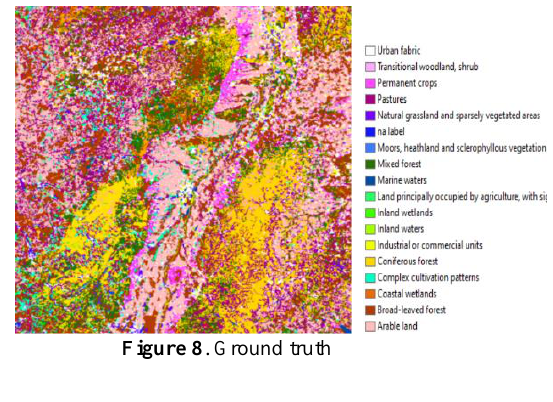
Figure 7. Network precision based on different patch dimensions